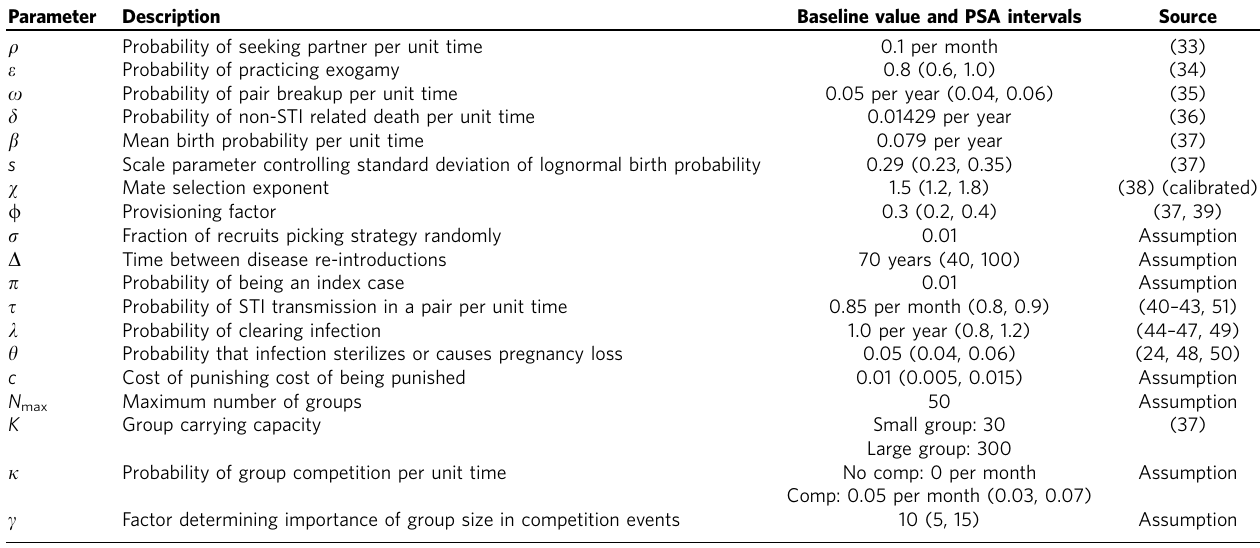
Table 1 | Model parameters, baseline values, intervals for probabilistic sensitivity analysis and literature sources.